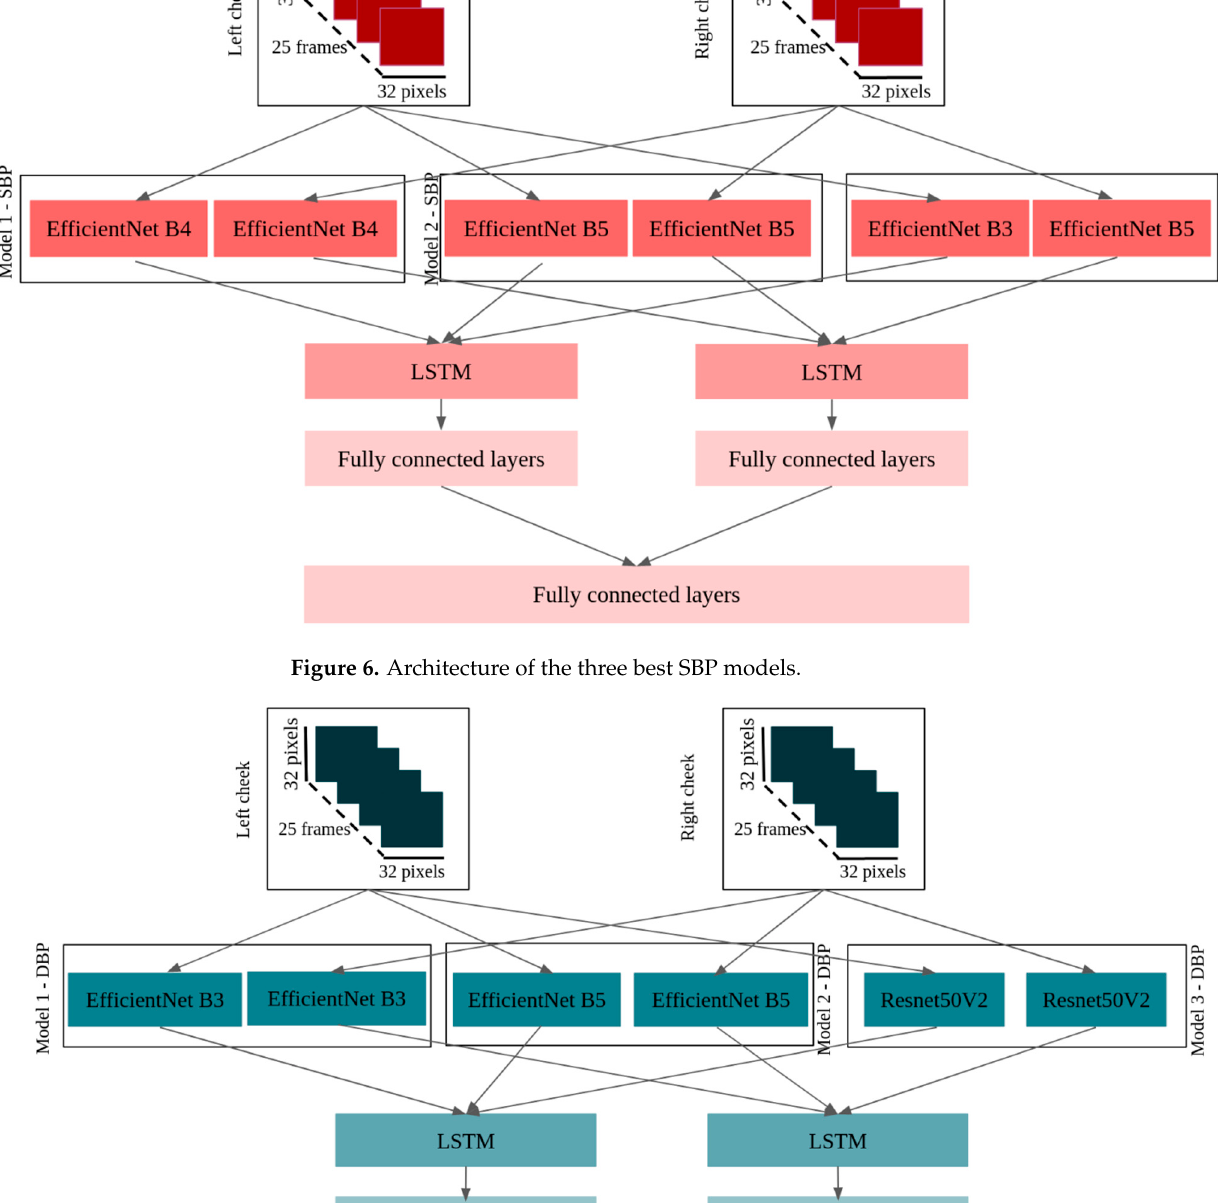
Table 4. Best combinations based on the lowest MAE and highest mean accuracy. Combination Type